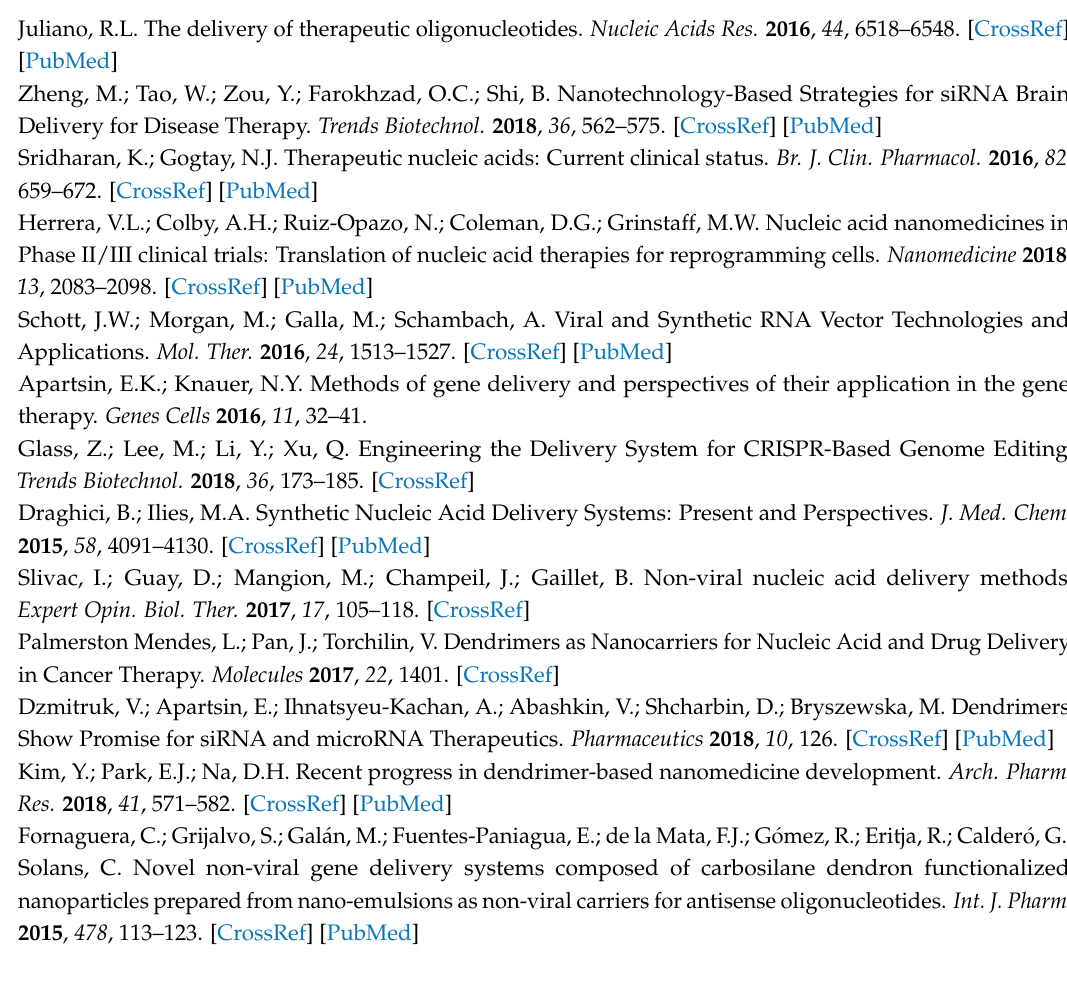
Figure S2 . CD spectroscopy curves and ellipticity changing profiles for the dendriplexes. Figure S3 . Zeta-potential profiles of the